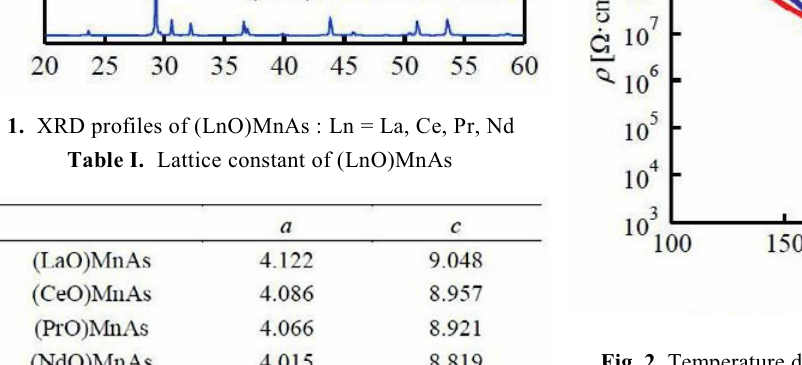
Fig. 2. Temperature dependence of electrical resistivity of